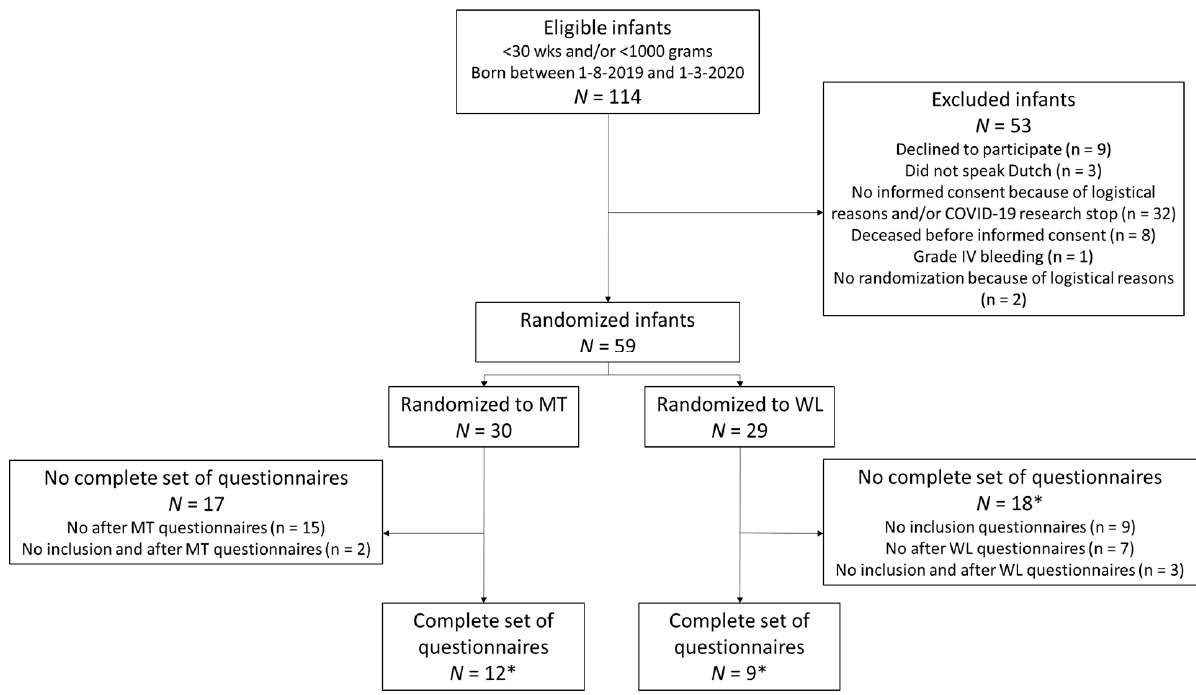
Figure 2. Flow chart of participants in the LPMT trial. LPMT — live-performed music therapy; WL — waitlist. * Including one set of twins.